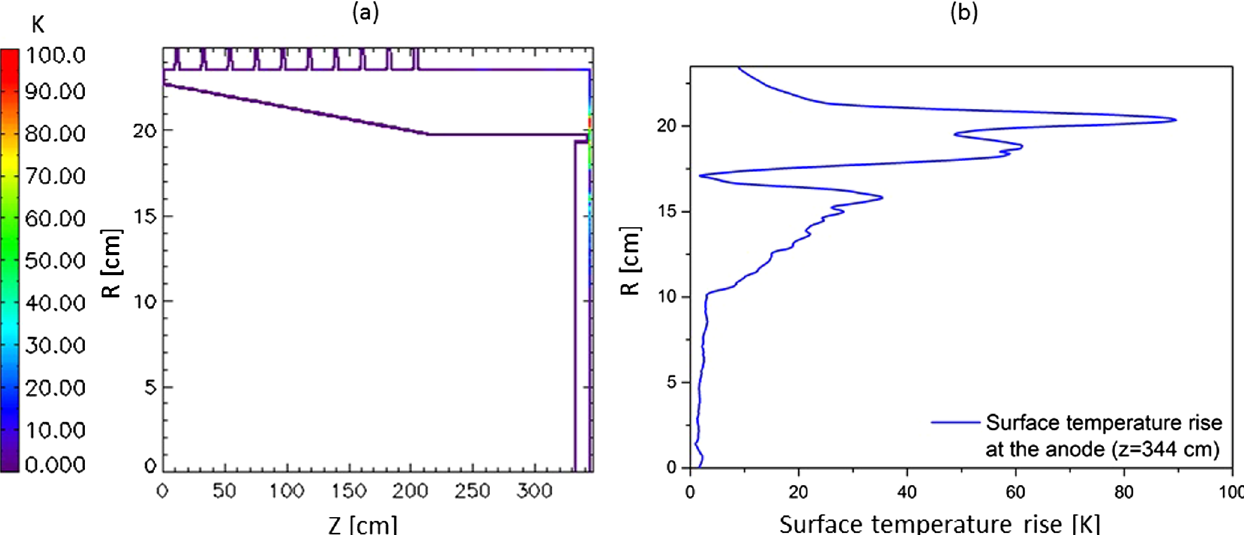
FIG. 10. (a) Simulated surface temperature rise inside the LTD. (b) Simulation of the radial profile of the temperature rise at the surface of the graphite